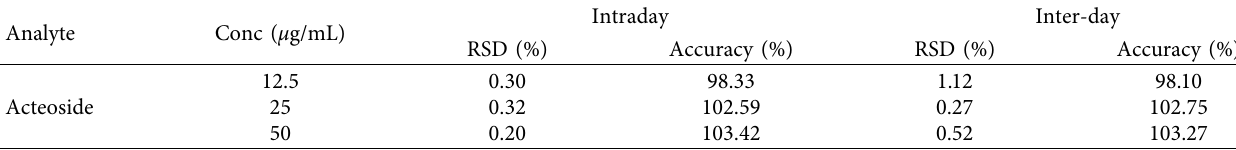
Table 4: Intraday and interday precision and accuracy values for the present method ( n � 3).